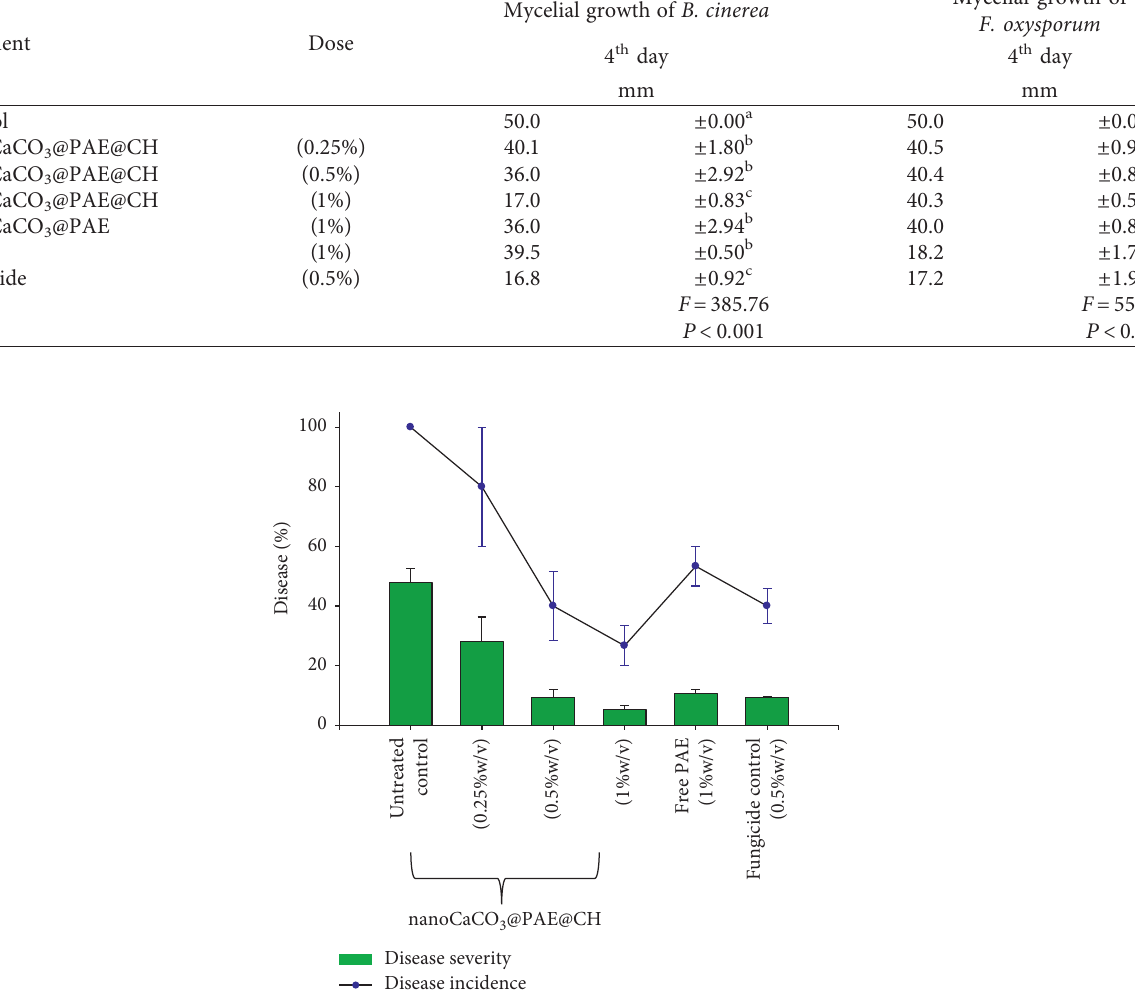
Table 1: In vitro mycelial growth of B. cinerea and F. oxysporum by increasing doses of nanoCaCO for each group are statistically different (LSD test, α � 0.05). Standard deviations of the means are indicated. Treatment Dose